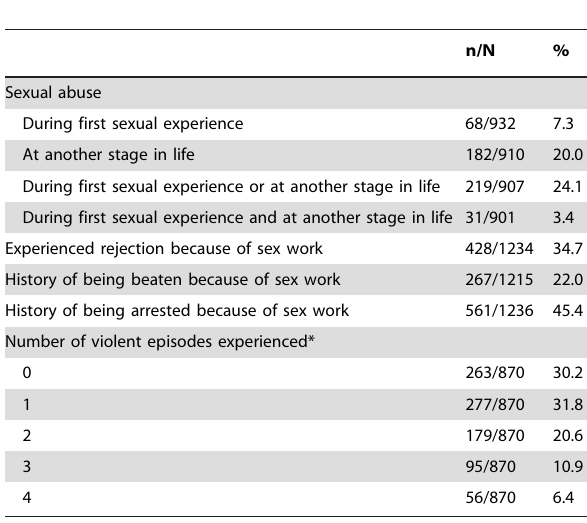
Table 2. Frequency of rejection and violent experiences in FSWs recruited in nine cities of Argentina between 2006 and